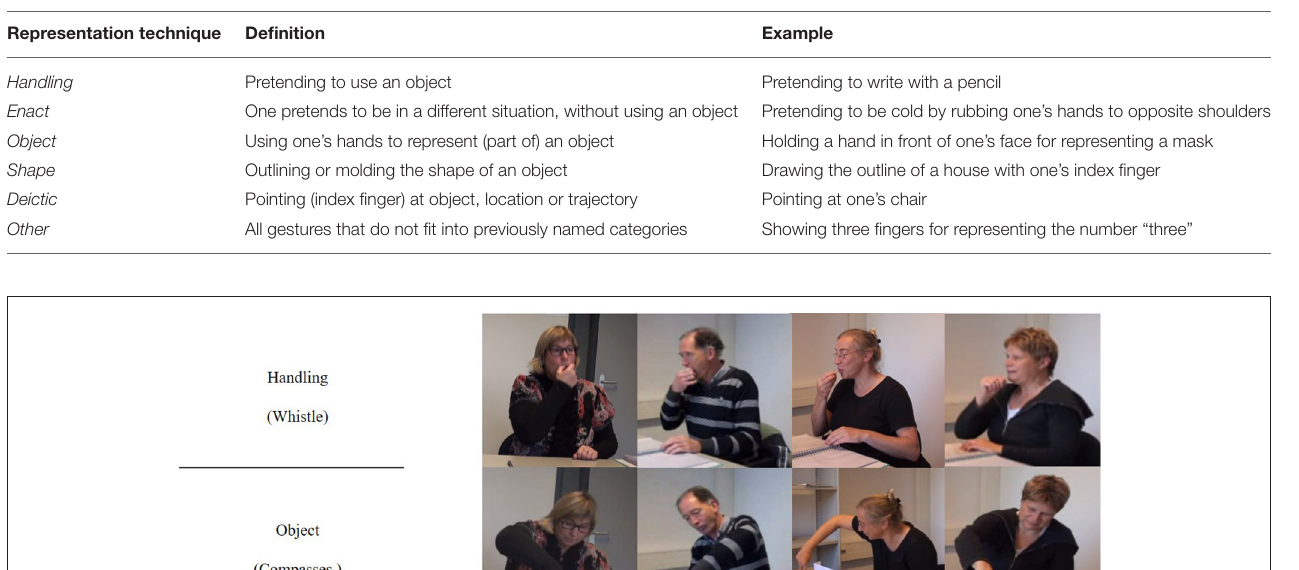
TABLE 1 | Coding scheme for representation techniques used (van Nispen et al., 2014, 2016).